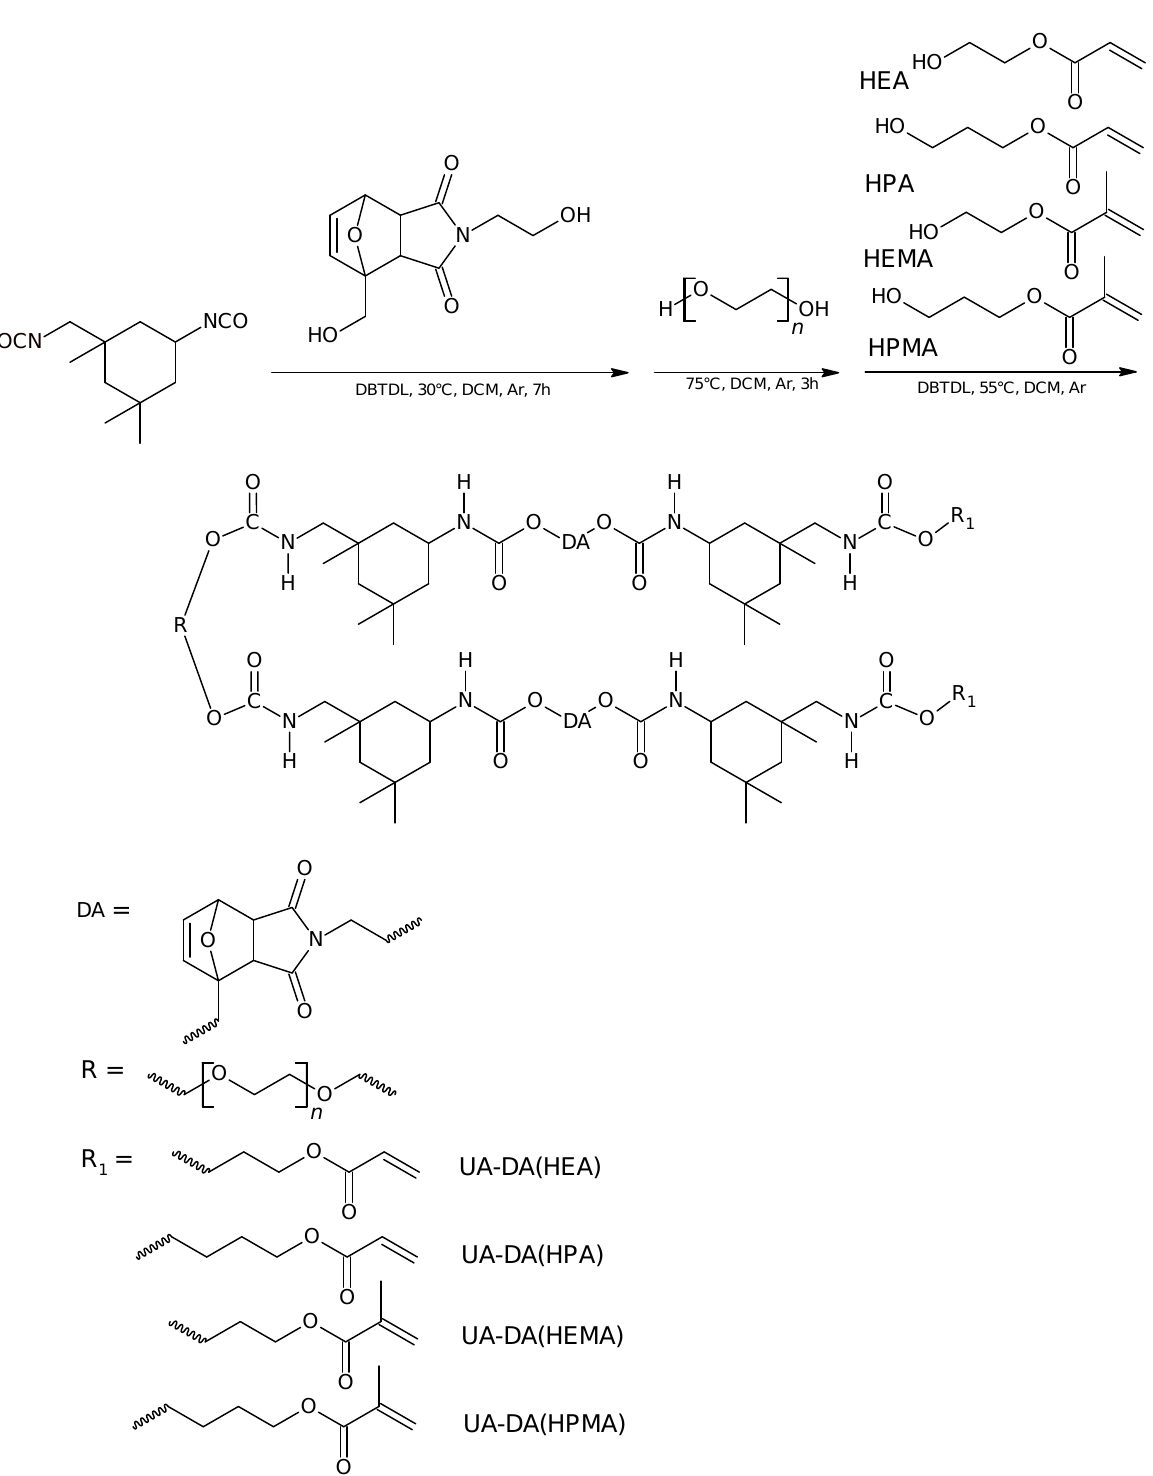
Figure 2. Scheme of the synthesis of the UV-curable urethane (meth)acrylates based on the DA structure (UA-DA) with various (meth)acrylate groups (HEA, HPA, HEMA, and HPMA).